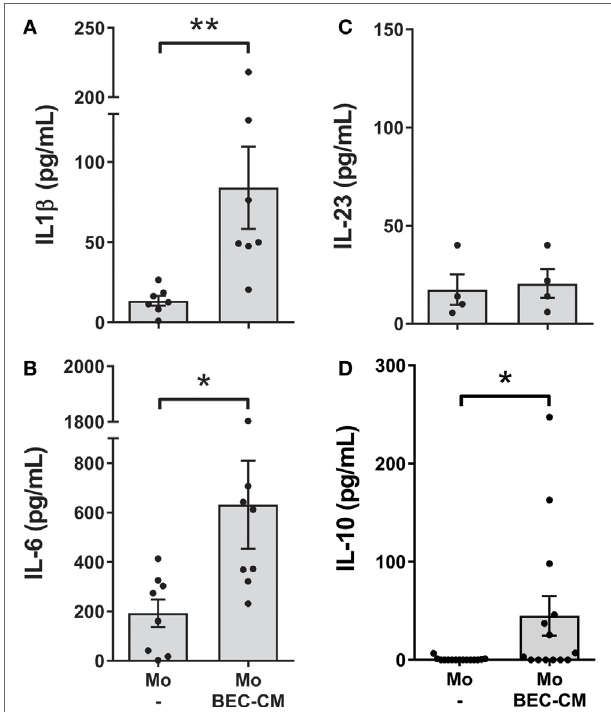
FigUre 3 | Bronchial epithelial cell-conditioned media (Bec-cM) stimulates the secretion of il1 β , il-6, and il-10 in monocytes . Monocytes were cultured for 48 h with medium alone or with BEC-CM. The secretion of cytokines was analyzed using the Luminex system or ELISA: ± SEM of at least four independent experiments. Statistical analysis was performed using Mann–Whitney test (* P < 0.05, ** P <